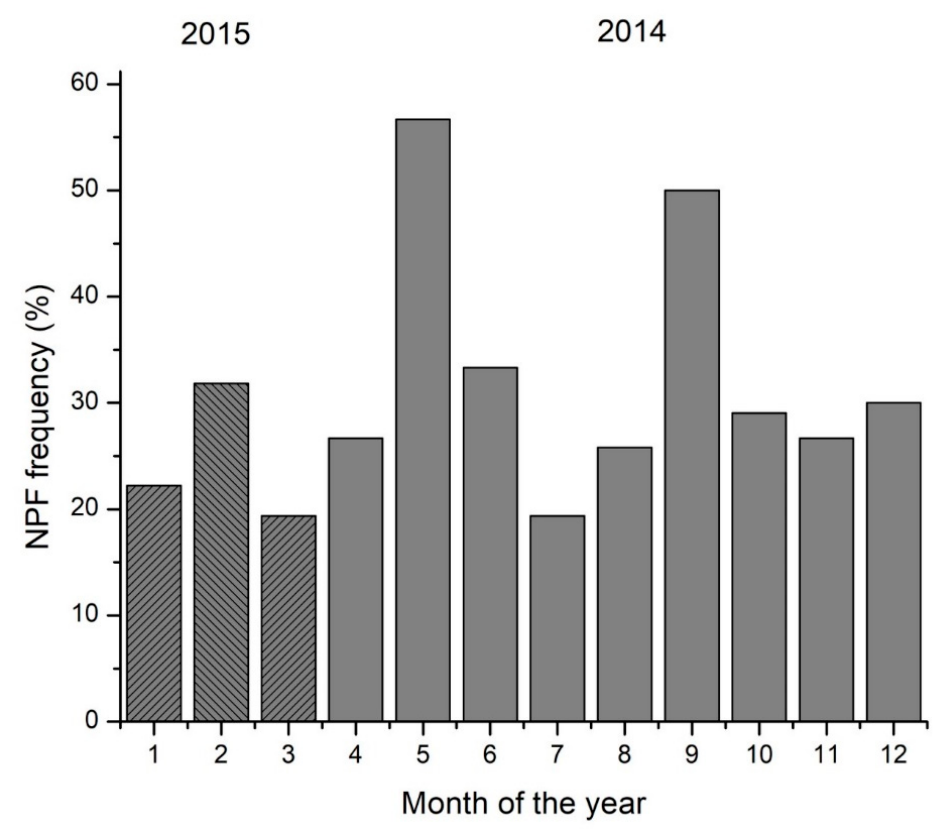
Figure 4. Monthly percentage frequency of occurrence of NPF at Finokalia station from March 2014 to March 2015 (full months are presented). Shaded columns indicate data from 2015.